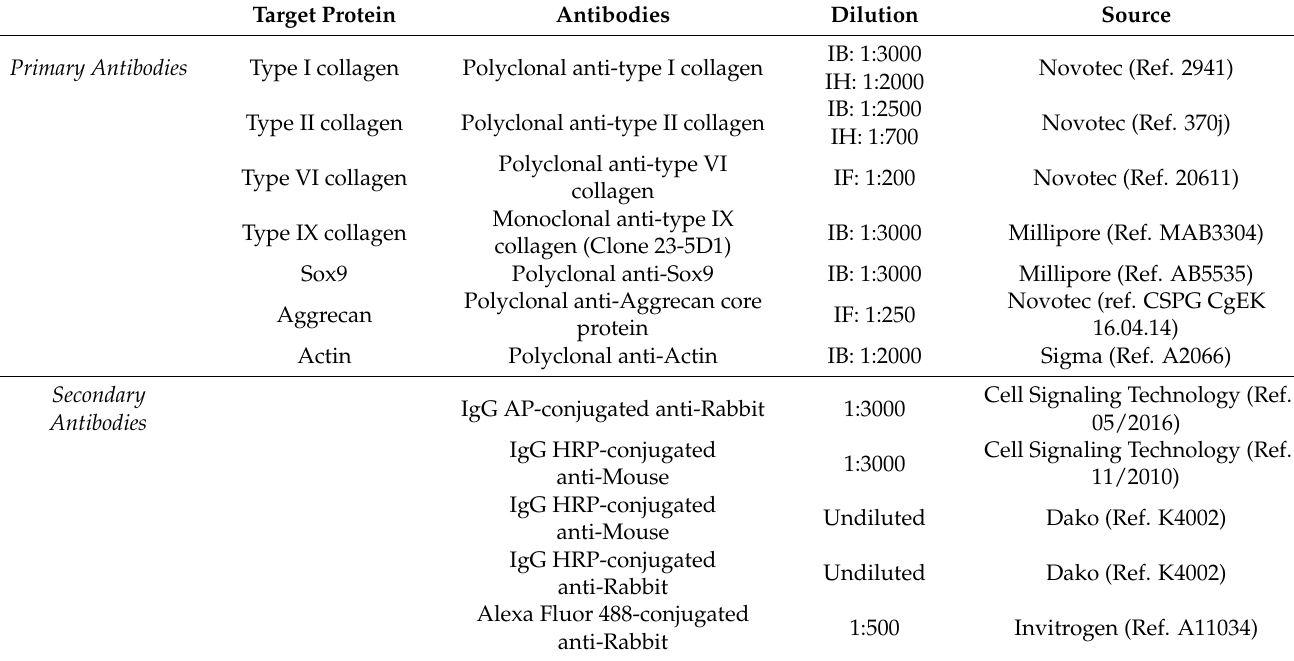
Table 1. Primary and Secondary